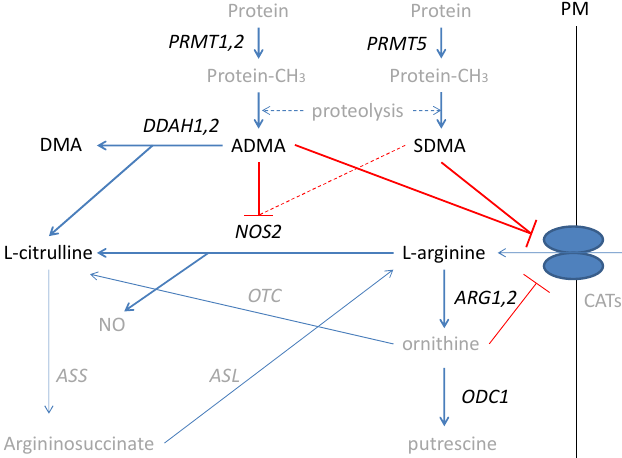
Figure 1. Simplified scheme of L-arginine/NO pathway. Pathway players analyzed in the current study are written in black: metabolites in straight font and enzymes in italics. Inhibition is marked in red (as a dashed line if the effect is weak). PRMT, arginine N-methyltransferase; PM, plasma membrane; CATs, cationic amino acid transporters; DDAH, dimethylarginine dimethylaminohydrolase; DMA, dimethylamine; ADMA, asymmetric dimethylarginine; SDMA, symmetric dimethylarginine; NOS, nitric oxide synthase; NO, nitric oxide; ARG, arginase; ODC, ornithine decarboxylase; ASS, argininosuccinate synthase; ASL, argininosuccinate lyase; OTC, ornithine transcarbamylase; protein-CH 3 , methylated proteins.